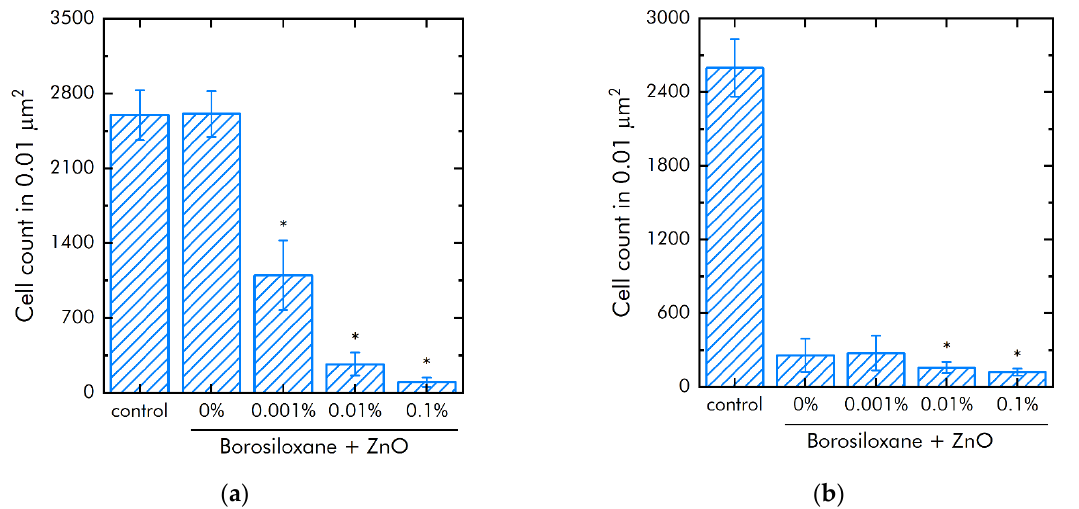
Figure 7. Influence of composite material based on borosiloxane and zinc oxide nanoparticles on the growth and develop- ment of E. coli : ( a ) Development of Escherichia coli . Incubation time is 24 h; ( b ) Effect of tearing off bacteria from a substrate using a composite material based on borosiloxane and zinc oxide nanoparticles; * indicate a significant difference at 5% level in comparison with the control (p < 0.05). Data are presented as mean values and standard errors.